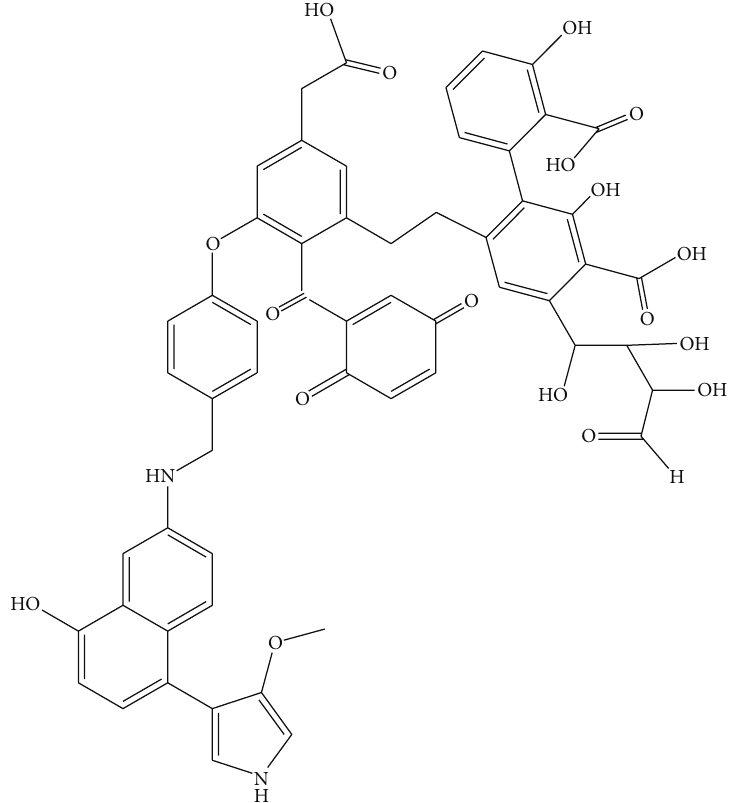
Figure 2: Structural fragment of humic acid